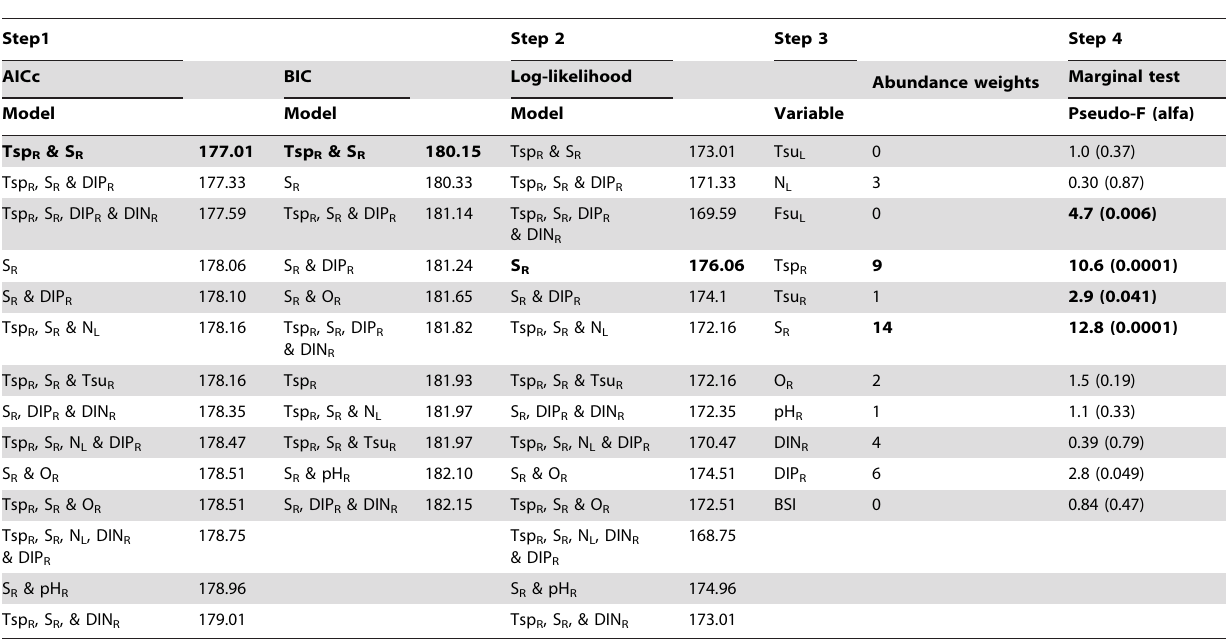
Table 5. Outcome of the DISTLM models for the Forsmark data